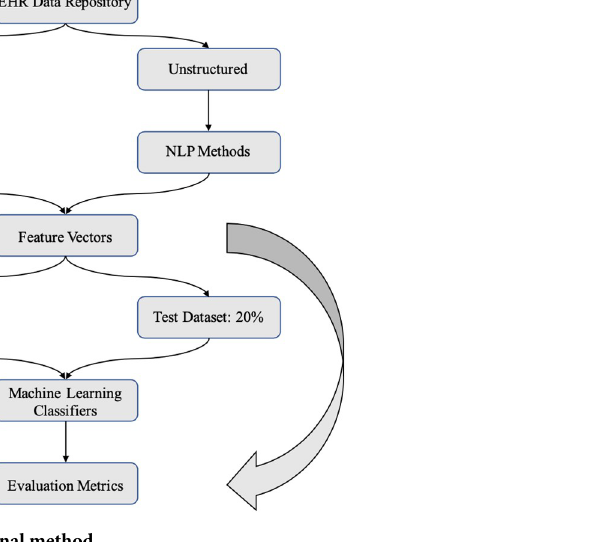
Fig 1. Overview of computational